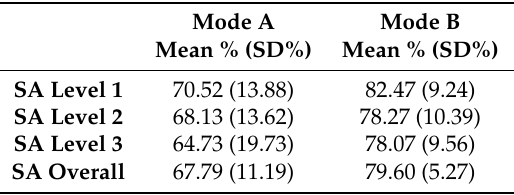
Table 2. Mean correct rates, with Standard Deviations (SD), of SAGAT questions under the two modalities: (A) Without inference and no collected data and (B) with inference on collect